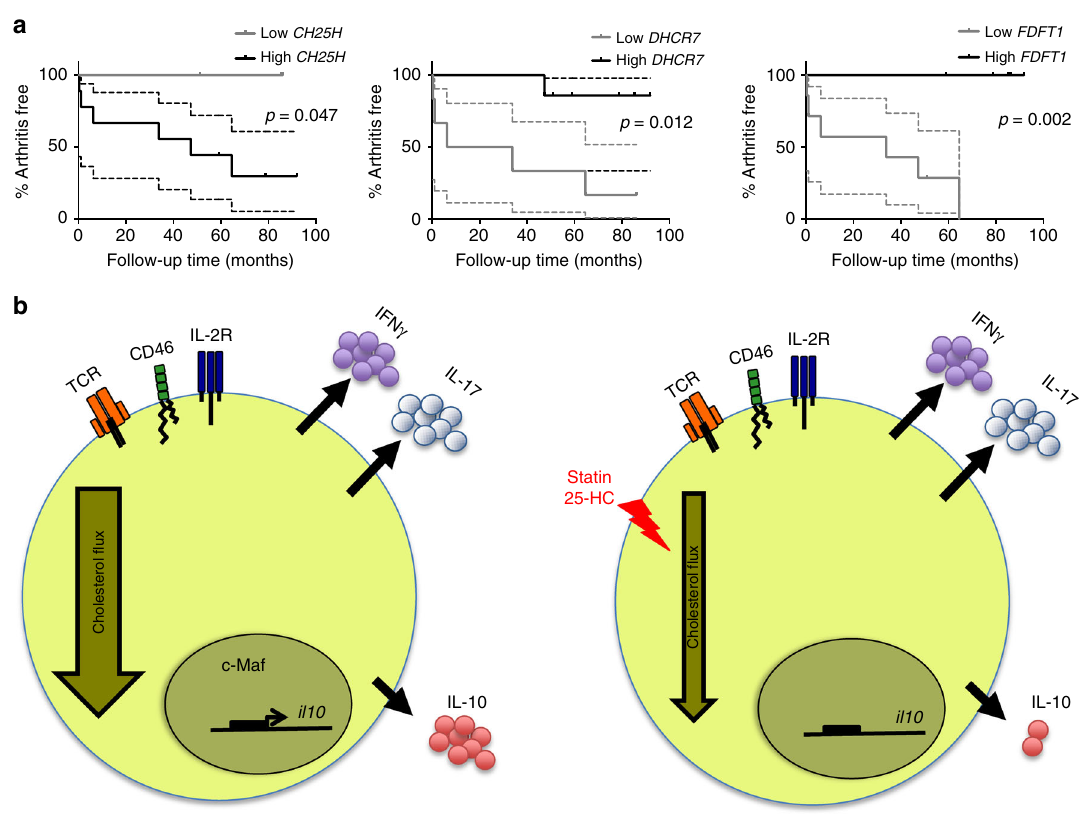
Fig. 6 Messenger RNA (mRNA) levels of cholesterol biosynthesis pathway (CBP) enzymes are related to disease progression in man. a Expression levels of cholesterol-25-hydroxylase ( CH25H ), FDFT1 and DHCR7 obtained from a gene expression pro fi ling study of synovial biopsies from 13 rheumatoid arthritis (RA)- risk individuals who were followed over time to investigate the development of arthritis. RA-risk individuals were strati fi ed into relative low or high expressers for the indicated genes, after which their arthritis-free survival was compared using a log-rank (Mantel – Cox) test. Graphs display arthritis-free survival curves including the 95% con fi dence interval (CI). b Schematic representation of interleukin-10 (IL-10) regulation by the cholesterol biosynthesis pathway. Normal cholesterol pathway activity is required for adequate transcription of the IL10 gene and IL-10 expression in T-helper effector cells (left); when the fl ux is reduced via statin or 25-hydroxycholesterol (25-HC) supplementation, c-Maf expression is downregulated and IL-10 gene transcription